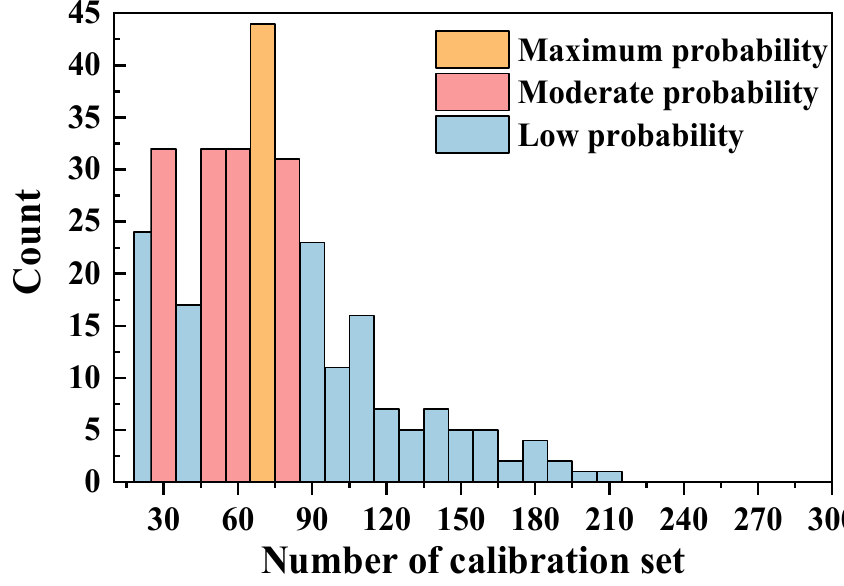
Figure 5. The statistics of the calibration set numbers for each unknown soil sample in the selection area using the SAM–PLSR method.